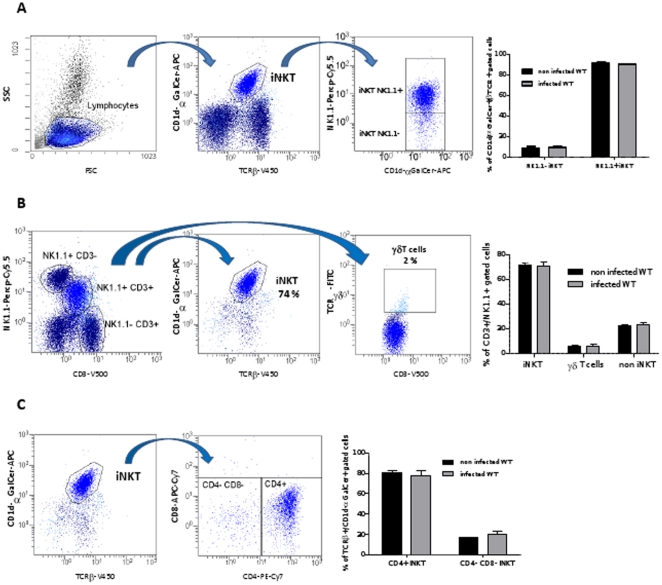
Phenotypic characterization of the iNKT cell infiltrate in the liver of WT mice on day 15 after infection with L.donovani.
Hepatic cell infiltration of C57BL/6 WT was analyzed by flow cytometry using anti-CD3-V500, anti-NK1.1-PerCP-Cy-5.5, anti-TCRβ-V450, anti TCR γδ-FITC, and αGalCer/CD1d tetramer-APC, anti-CD4-PE-Cy7, anti-CD8-APC-Cy7. (A) Gating strategy allowing to estimate the low percentage of NK1.1- and NK1.1+ cells among TCRβ+/αGalCer/CD1d tetramer+ cells. (B) Gating strategy and evaluation of the percentage of γδ-T cells and non iNKT cells among CD3+/NK1.1+. (C) Percentage of CD4+ and CD4-/CD8- cells among iNKT cells (TCRβ+/αGalCer/CD1d tetramer+). This panel is representative of three independent experiments.